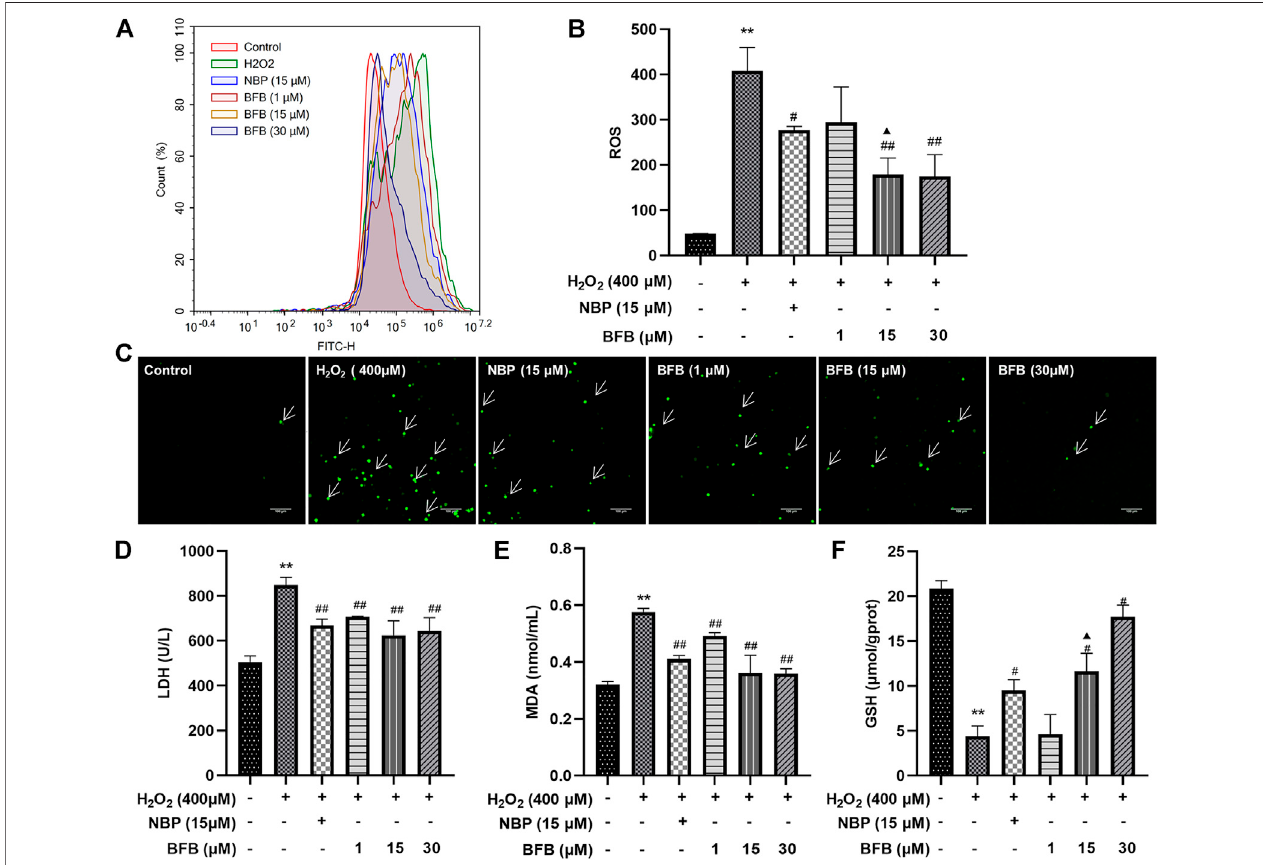
FIGURE 2 | BFB alleviated OS characteristics in H 2 O 2 -exposed PC12 cells. H 2 O 2 (400 μ m) was added to treat PC12 cells for a 24-h period with elevating concentrations of BFB (1, 15, 30 μ m) or NBP (15 μ m) for a 3-h period, followed by measurement of oxidative stress-associated indicators (A,B) ROS generation analyzed by DCFH-DA through FCM (C) Fluorescence microscopy images of the protective effects of BFB against H 2 O 2 . Administration of 400 µm H 2 O 2 signi fi cantly increased ROS accumulation relative to Control. BFB signi fi cantly decreased ROS compared with 400 µm H 2 O 2 group, and the reduction in ROS expression increased with the BFB concentration. Cell GSH (D) LDH leakage (E) MDA (F) GSH contents were determined using commercially available kits. Data were analyzed by mean ± SD from 3 separate assays. * p < 0.05, ** p < 0.01, versus control, # p < 0.05, ## p < 0.01, versus H 2 O 2 group. ▲ p < 0.05, ▲▲ p < 0.01, versus NBP group.